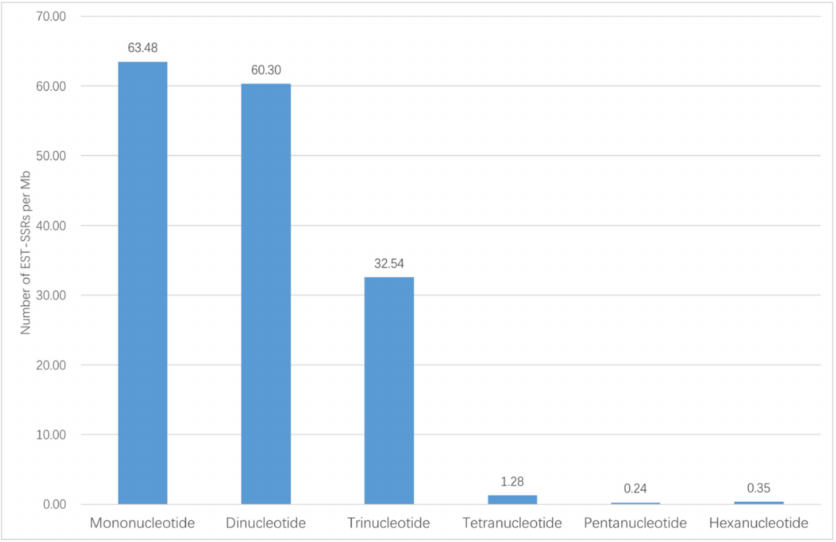
Figure 1. General information of the percentage for six EST-SSR types.